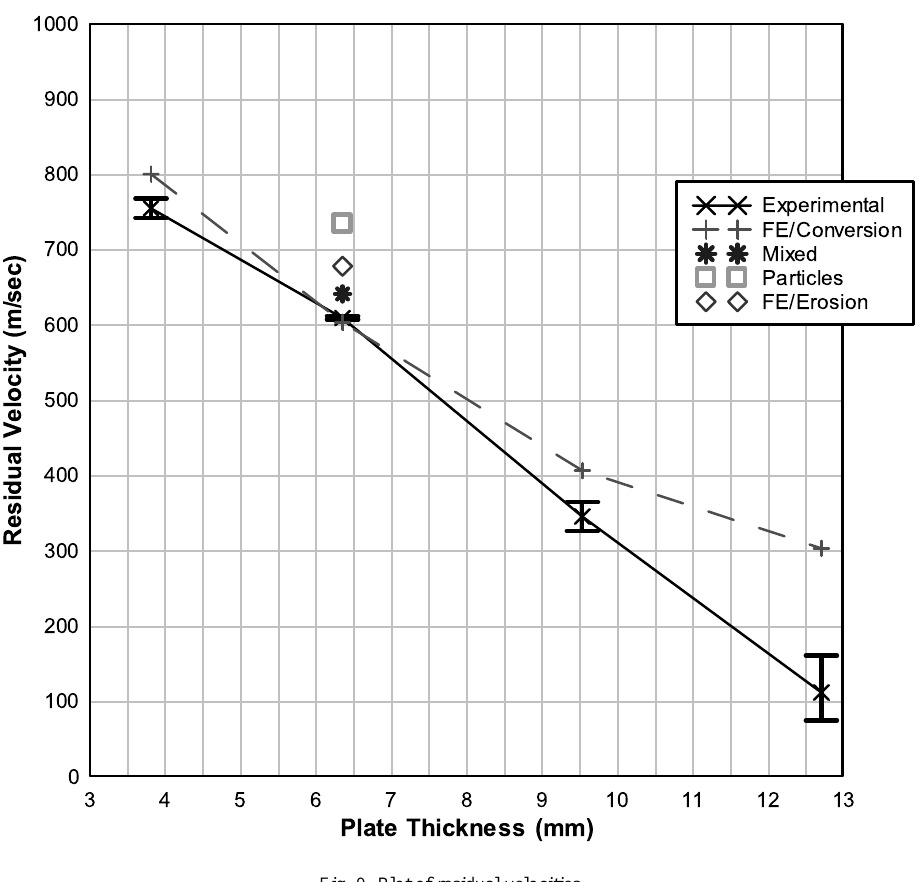
Fig. 9. Plot of residual